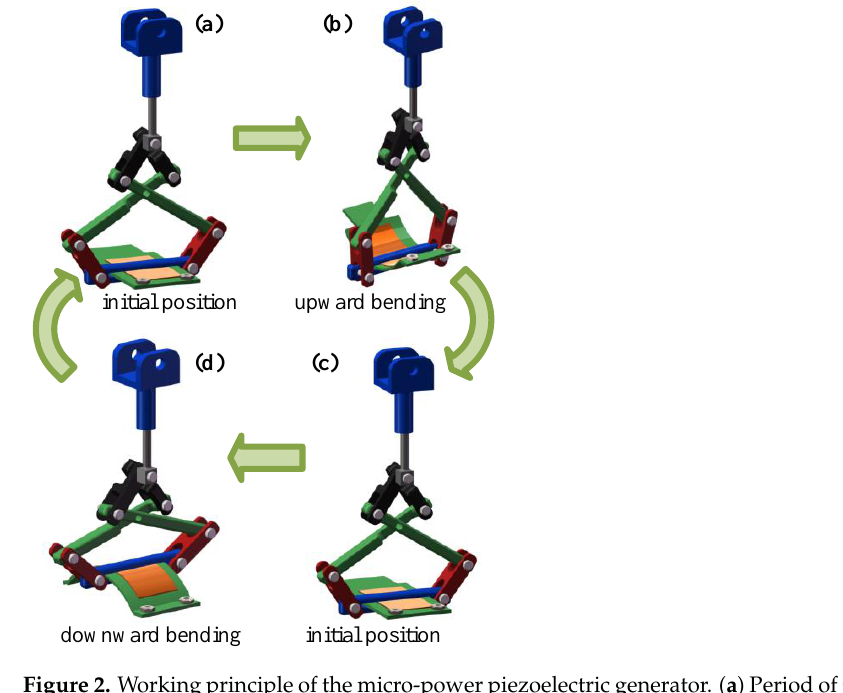
Figure 2. Working principle of the micro-power piezoelectric generator. ( a ) Period of 0 or T; ( b ) period of T/4; ( c ) period of T/2; ( d ) period of 3T/4.